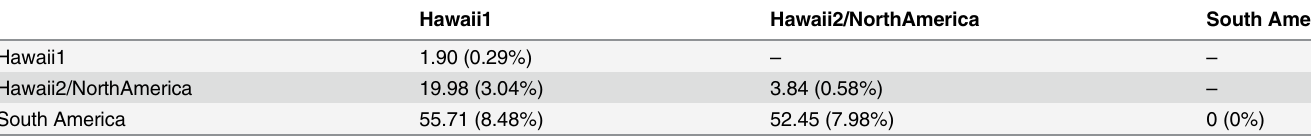
Table 2. Average pairwise genetic distances ( COI ) within and between COI